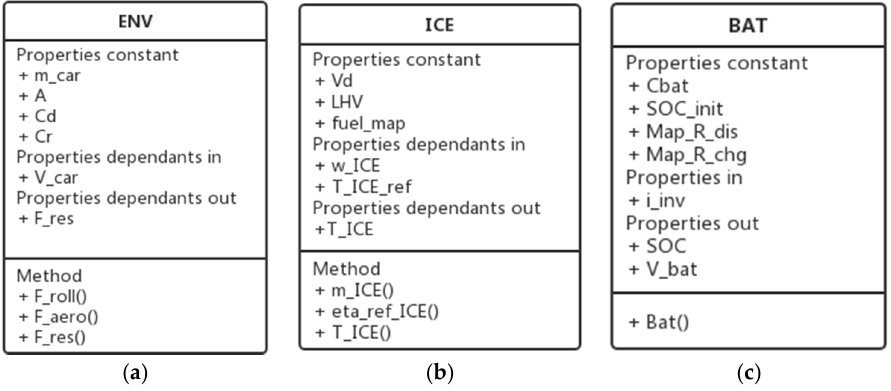
Figure 8. UML of environment, ICE and battery OOP model: ( a ) UML of ENV; ( b ) UML of ICE; and ( c ) UML of BAT.